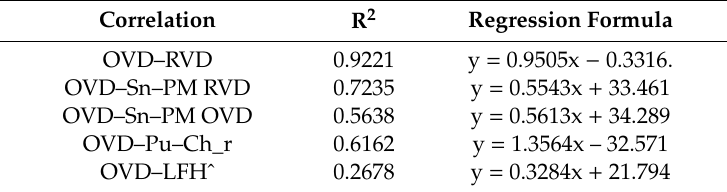
Table 4. Regression equation to predict the OVD from di ff erent anthropometric and cephalometric measurements (R 2 >